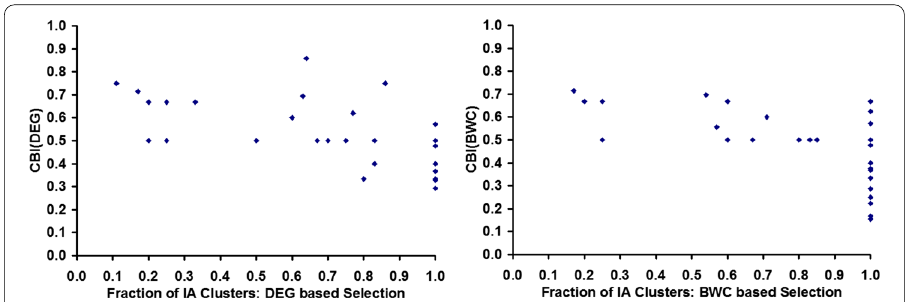
Fig. 11 Fraction of Louvain clusters with at least one initial adopter (IA) node versus Custer blocking index (CBI) values for the real-world networks